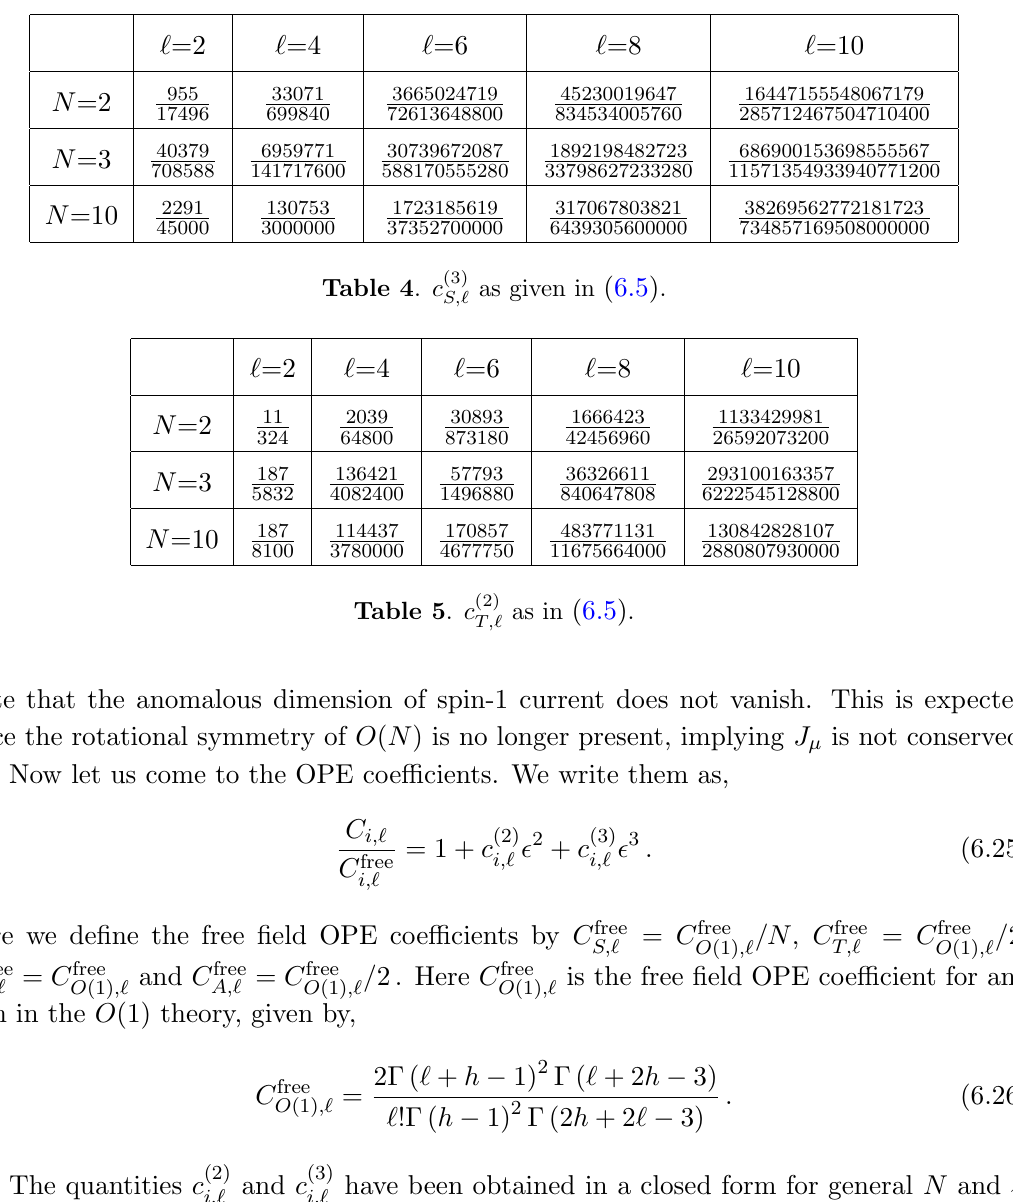
as given in (6.5) . S;‘